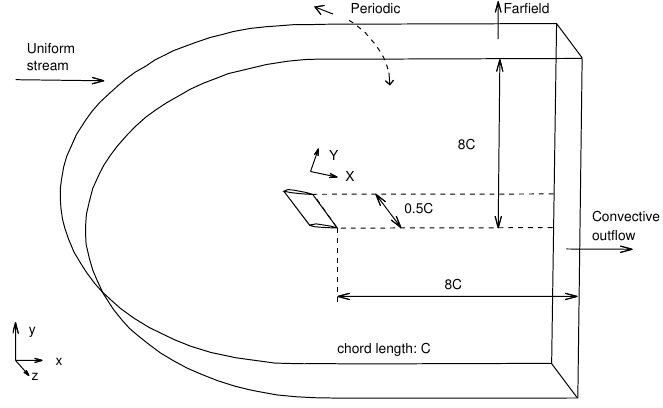
Figure 2. Computational domain and boundary